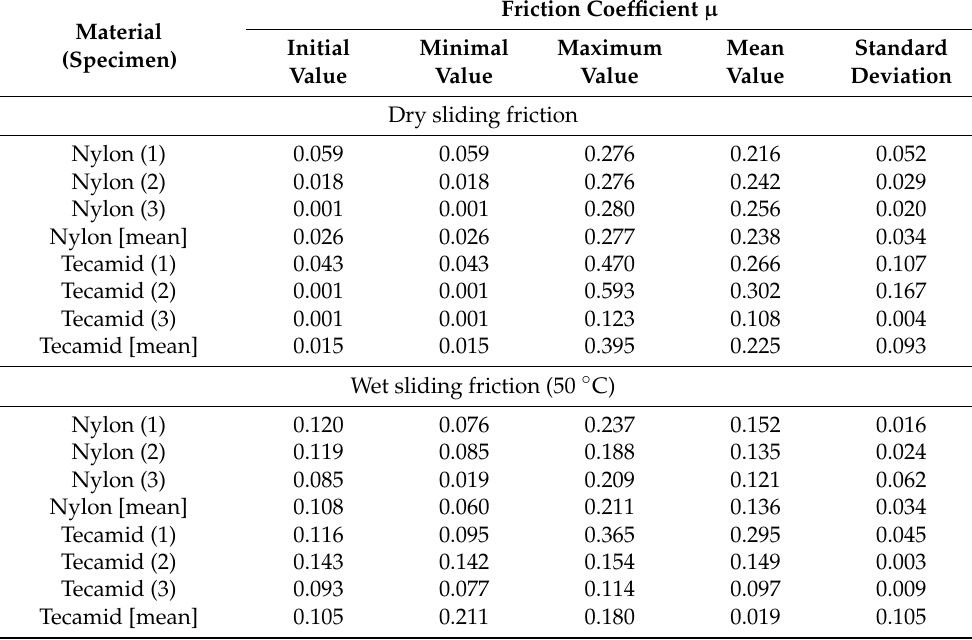
Table 4. Values of the friction coefficient of plastics.